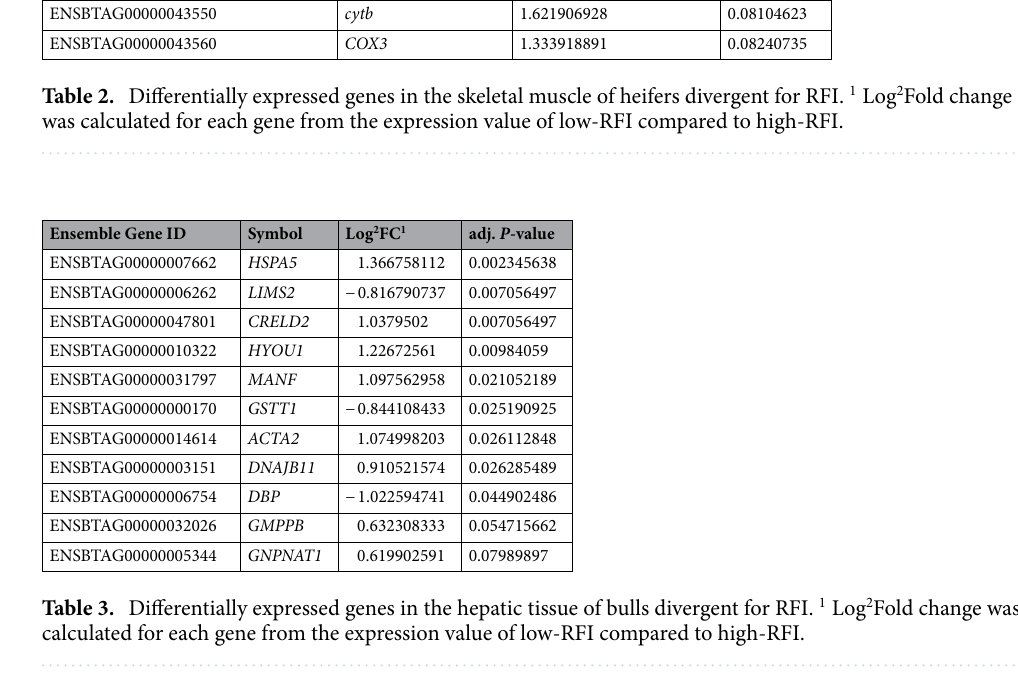
Table 3. Differentially expressed genes in the hepatic tissue of bulls divergent for RFI. 1 Log 2 Fold change was calculated for each gene from the expression value of low-RFI compared to high-RFI.